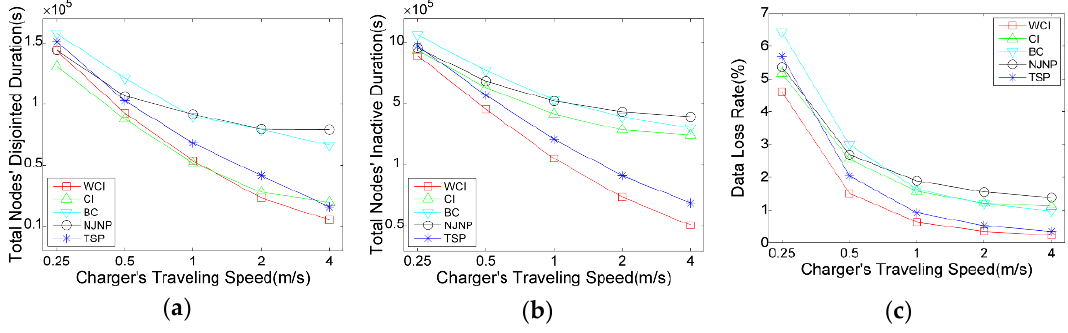
Figure 7. Impact of v on the charging scheduling algorithms: ( a ) Total nodes’ disjointed time; ( b ) Total nodes’ inactive time; ( c ) Network’s data loss rate.